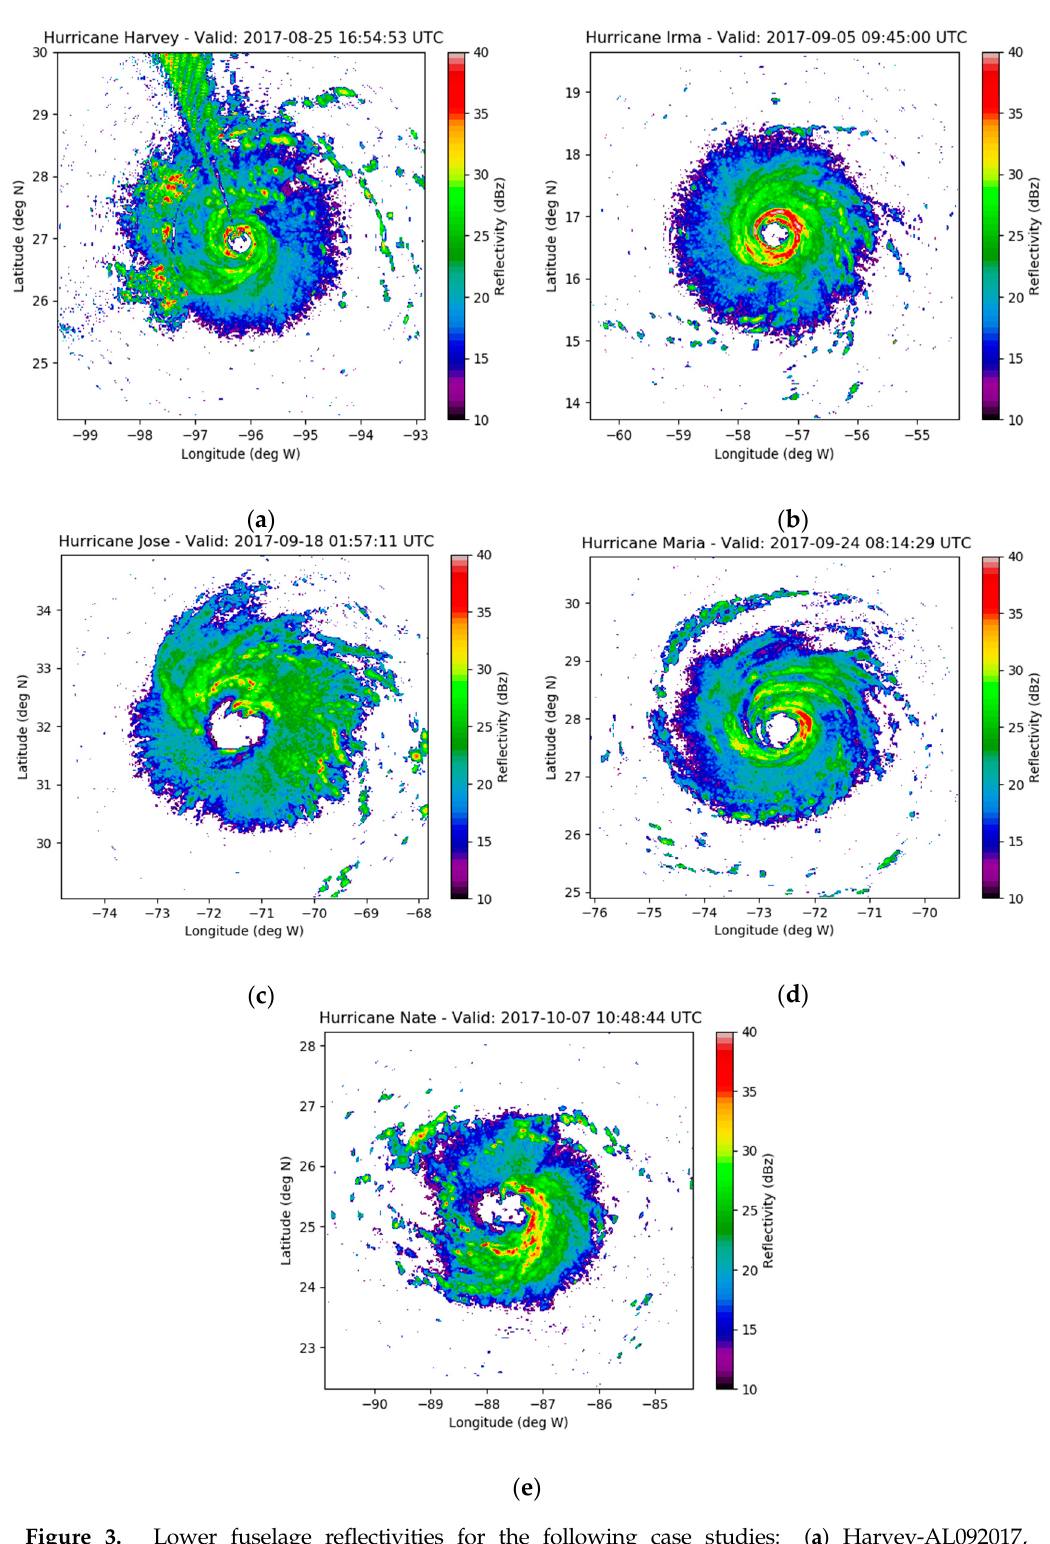
Figure 3. Lower fuselage reflectivities for the following case studies: ( a ) Harvey-AL092017, ( b ) Irma-AL112017, ( c ) Jose-AL122017, ( d ) Maria-AL152017, and ( e ) Nate-AL162017. Harvey’s reflectivity plot shows partial obstruction of the radar signal from the aircraft itself, which is known as radiofrequency